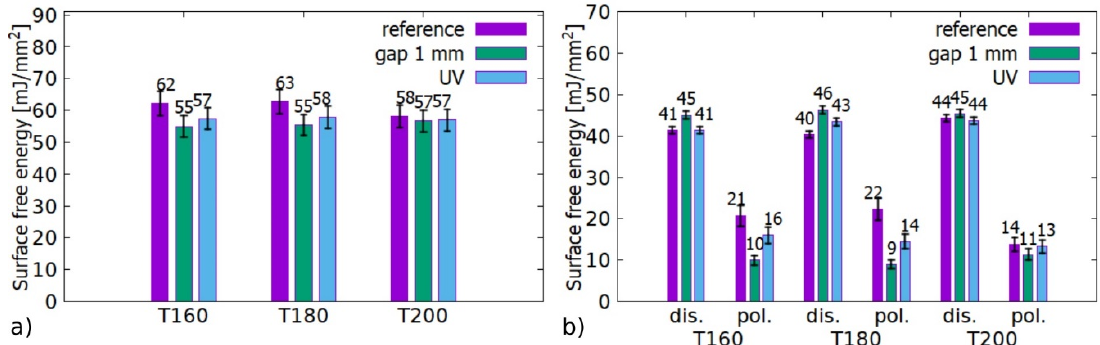
Figure 12. Comparison of surface energies of reference samples, plasma treated at 1 mm gap and treated by plasma generated UV. ( a ) Total SFE, ( b ) division into SFE components.